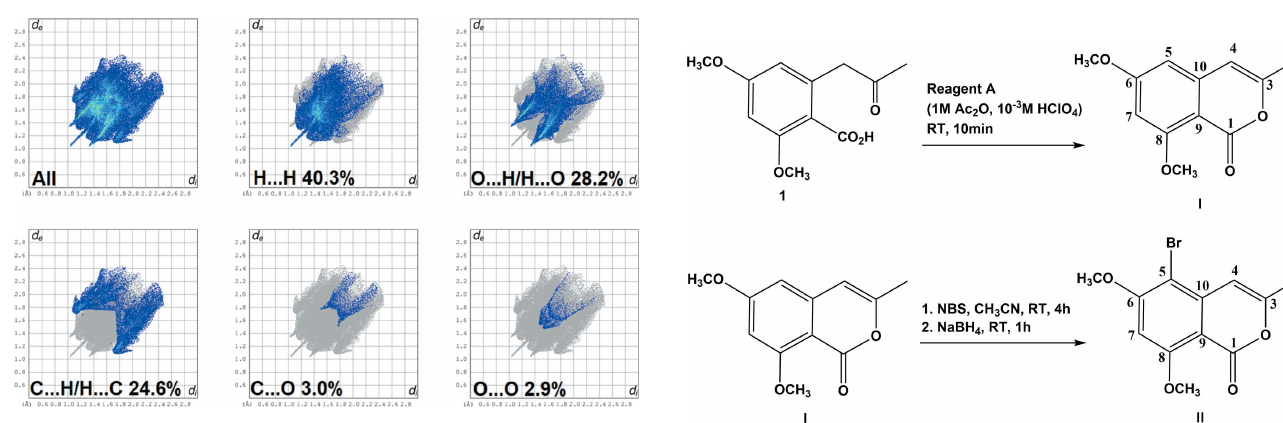
Figure 9 Reaction schemes for the syntheses of compounds I and II , with atom- labelling schemes in relation to the NMR spectra (see x 6. Synthesis and crystallization ).